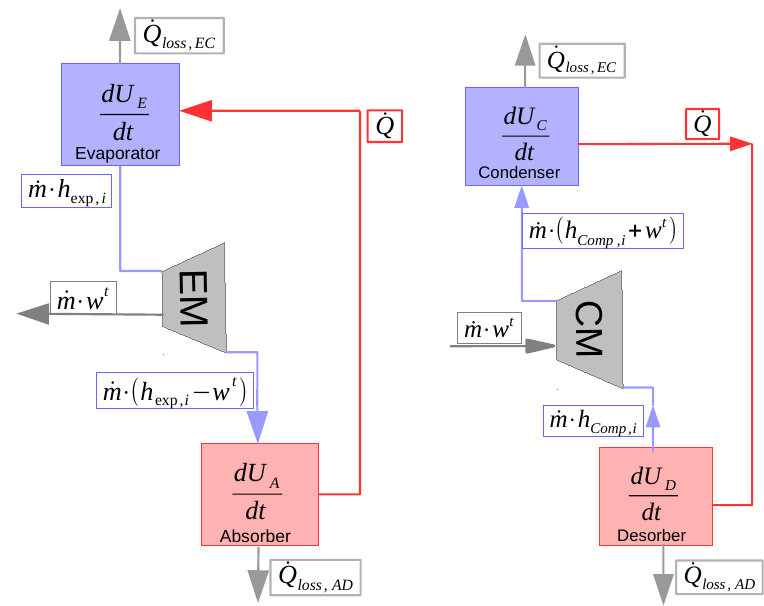
Figure 3. System configuration (A): Directly coupled HXs—mechanical discharging ( left ), mechanical charging ( right